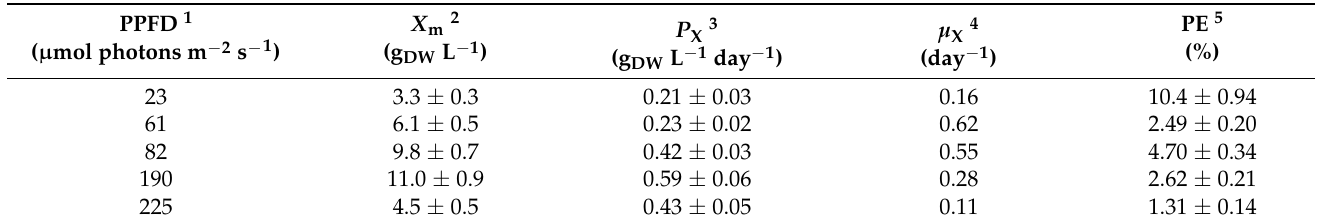
Table 1. Results of batch Arthrospira platensis cultivations carried out in the helical photobioreactor under different light